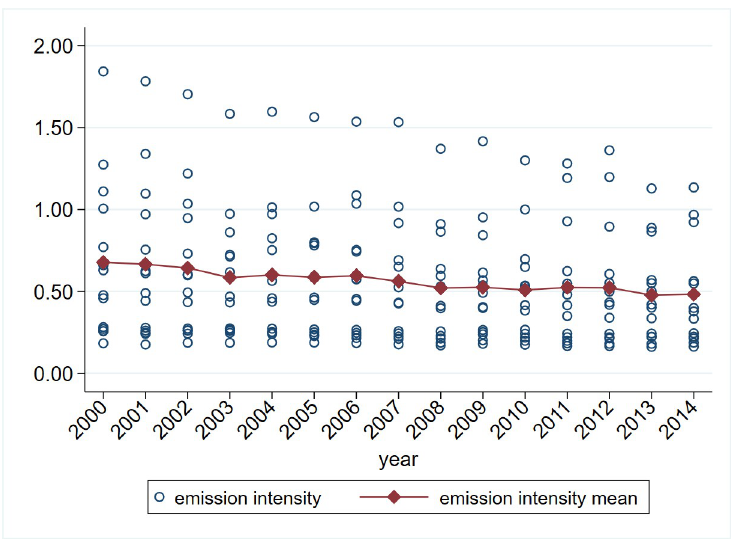
Fig 5. Heterogeneity of emission intensity across years. Source: Authors’ calculations (in STATA 15) based on data from WIOD Environmental Accounts (Update 2000–2016), WIOD, Release 2016 and FAO Emissions Database.